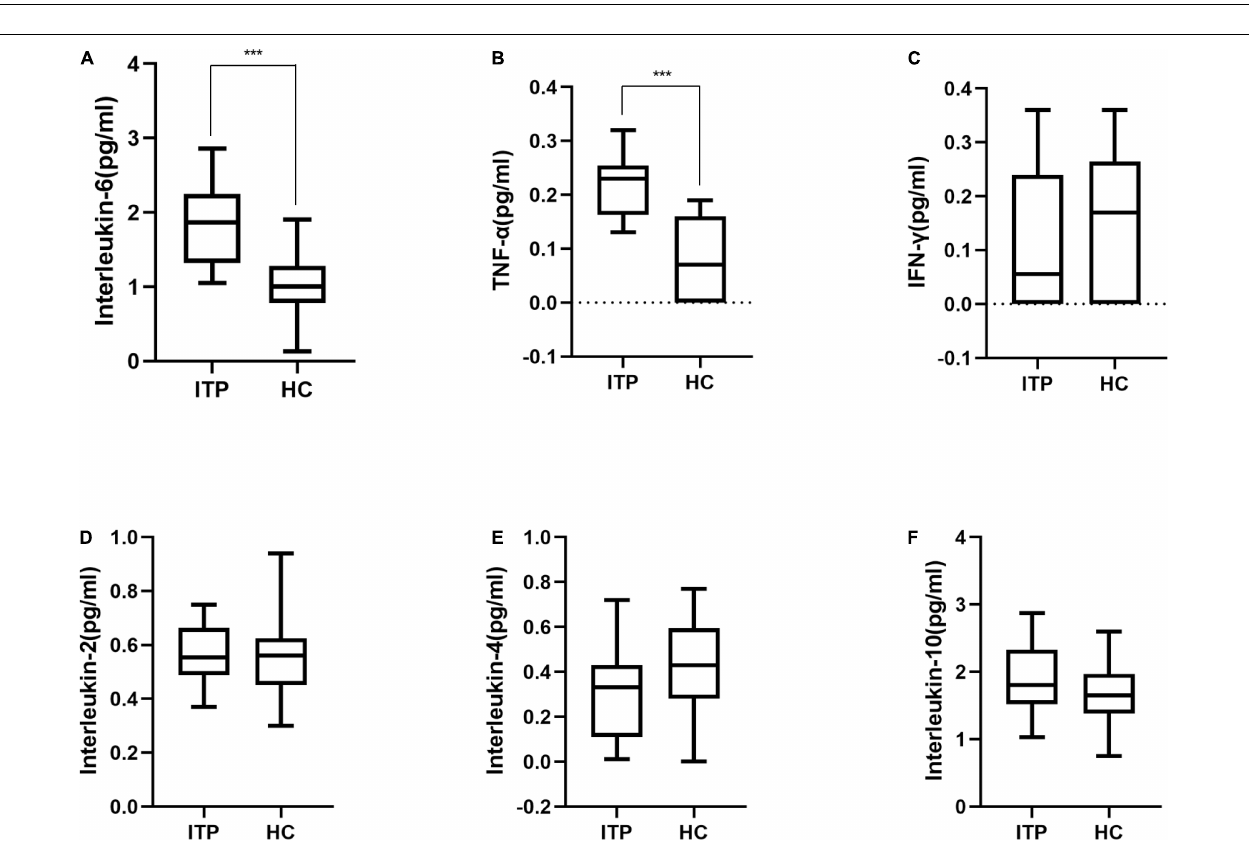
FIGURE 4 | Box plot of cytokines in ITP patients and healthy controls. (A) Interleukin-6, (B) TNF- α , (C) IFN- γ , (D) Interleukin-2, (E) Interleukin-4, (F) Interleukin-10. These cytokines were all detected by flow cytometry. *** p < 0.001.